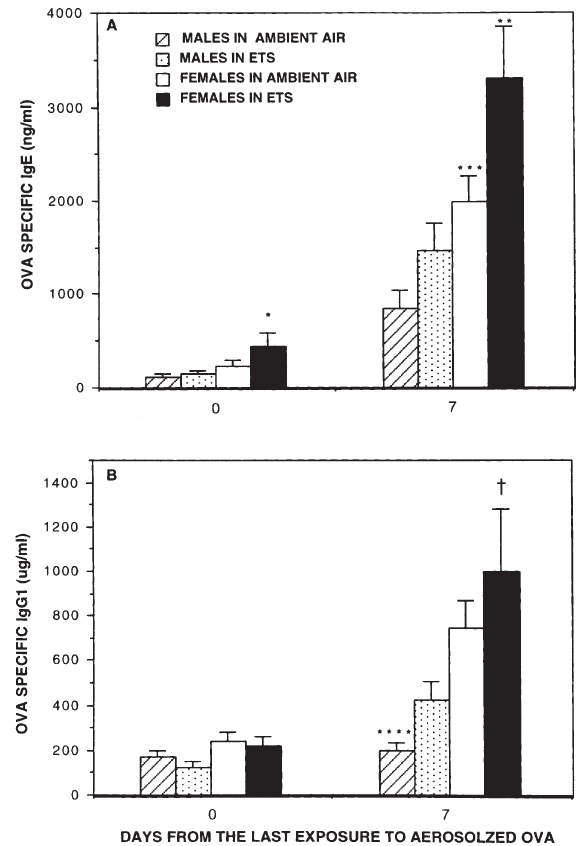
FIGURE 3 The immune response of OVA immunized BALB/c mice after long-term exposure to ETS or ambient air. (A) OVA specific IgE (ng/ml). (B) OVA specific IgG1 m g/ml. * p ¼ 0 : 03 vs. females in ambient air. ** p ¼ 0 : 019 vs. males in ETS. *** p ¼ 0 : 0008 vs. males in ambient air. **** p ¼ 0 : 002 vs. males in ETS. † p , 0 : 05 compared to males in ETS or ambient